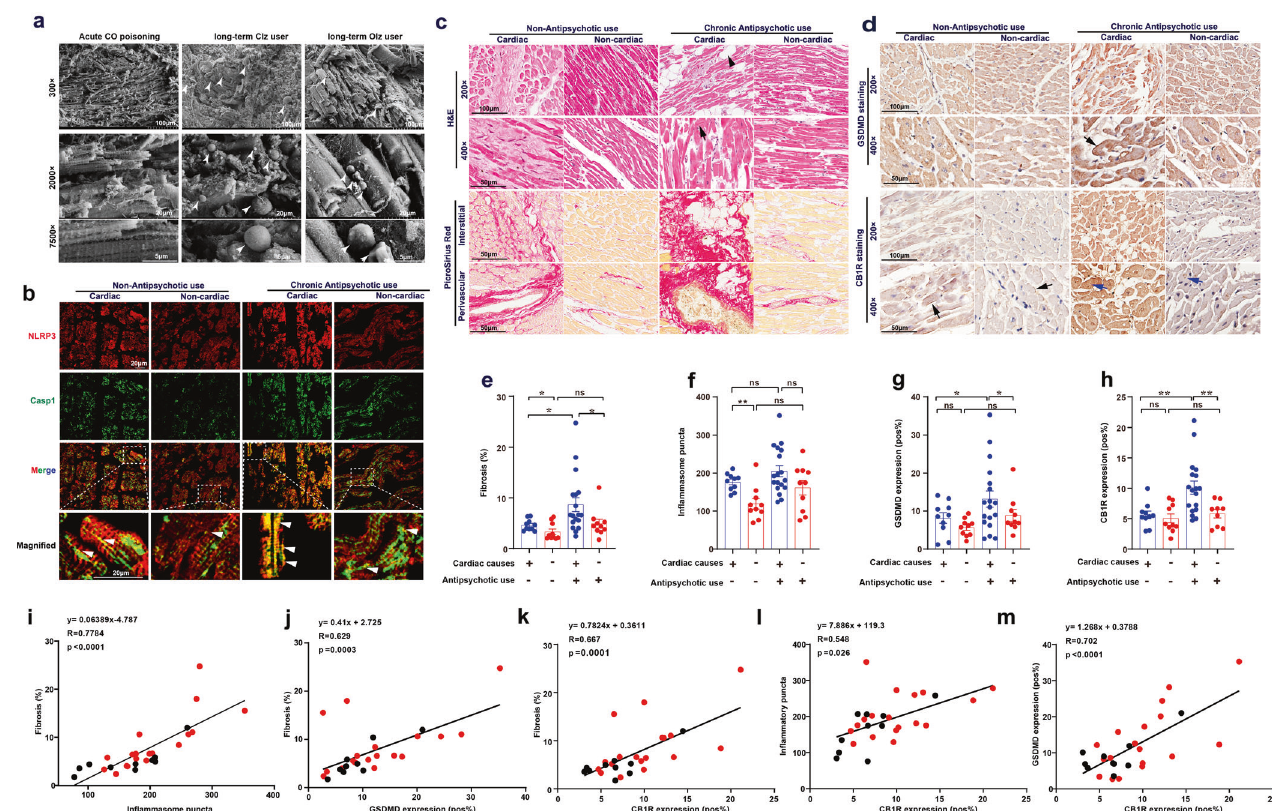
Fig. 7 CB1R expression positively correlated with antipsychotics-induced pyroptosis and fi brosis in human specimens. a Scanning electron microscopy of hearts from a control (acute CO poisoning) case and two antipsychotic drug (Clz, Olz) users. Arrowheads indicates bubble-like pyroptotic protrusions. b Immuno fl uorescence analysis of NLRP3 (red) and Casp1 (green) in the four categories of human heart specimens. Arrowheads indicated NLRP3 in fl ammasome specks (yellow signal). Scale bar = 20 μ m. c H&E staining and PicroSirius red staining of human heart sections. Black arrowhead indicated fatty- fi bro tissues and black arrow indicated contraction band necrosis. Magni fi cation = 200× for upper images and 400× for lower images at each staining. d Immunohistochemistry staining of GSDMD and CB1R within the human heart sections. Black arrows indicated membrane-gathering, whereas blue arrows indicated cytoplasm-localization. e – h Quantitative analysis of fi brosis, in fl ammasome specks, GSDMD expression, and CB1R expression within the heart sections under 400× ( n = 18 for antipsychotics users with cardiac deaths, and n = 10 for the other three groups). i – m Linear correlation analysis. Red dots indicated antipsychotics users with cardiac deaths ( n = 18) and black dots indicated antipsychotics users with non-cardiac deaths ( n = 10). All quanti fi cation represents the